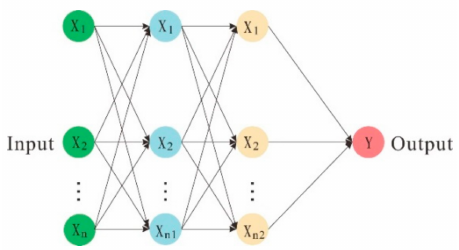
Figure 4. MLPNN structure.